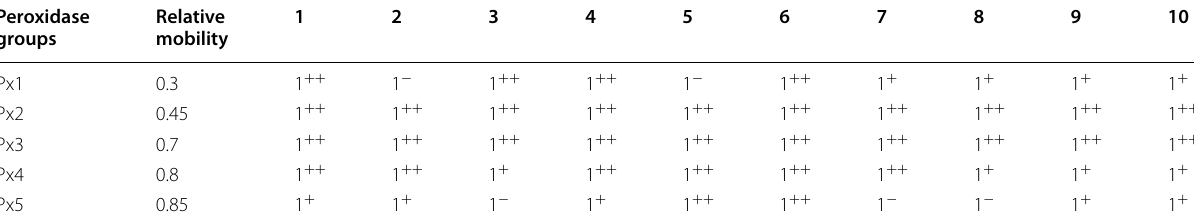
Table 3 Isomers of peroxidase enzymes and their retention factor (Rf) in response to F. oxysporum and endophytic isolates on tomato plants Peroxidase groups